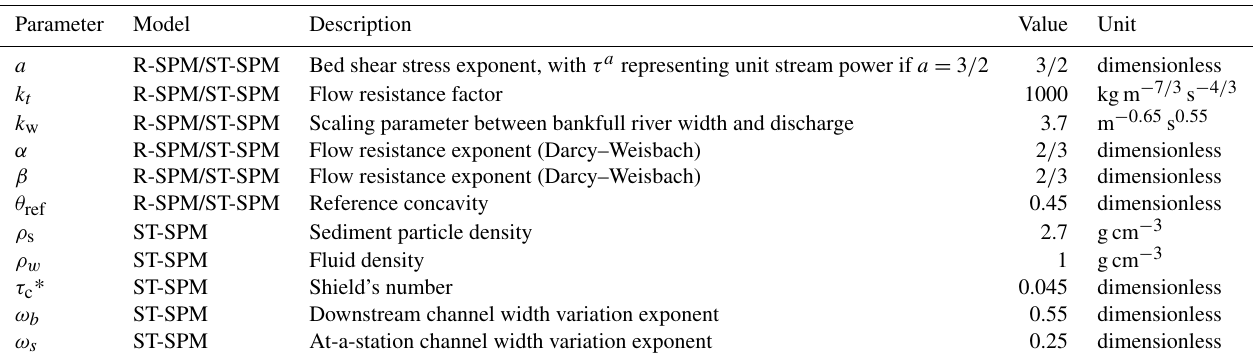
Table 1. Constant model parameters.